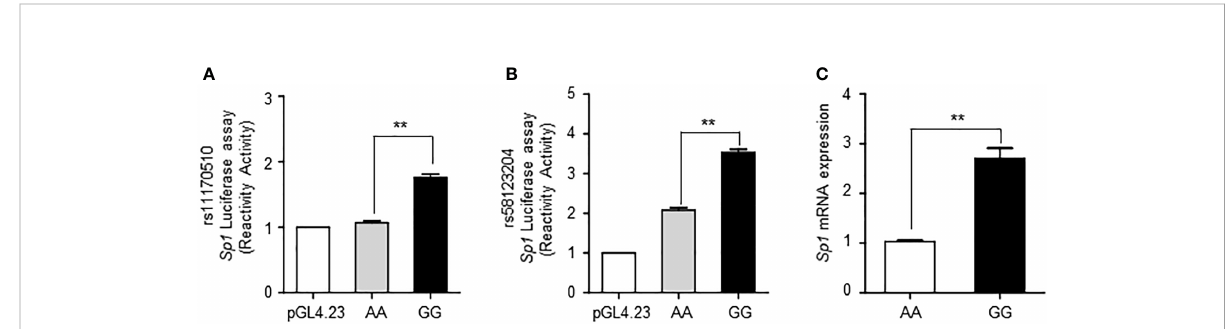
FIGURE 2 Functional effects of SNPs rs11170510 and rs58123204 on Sp1 expression. (A) HEK293 cells were transfected with the mock vector (pGL4.23 vector), major A allele of the rs11170510 or minor G allele of the rs11170510-luciferase reporter constructs. Cells were subjected to a luciferase assay. (B) HEK293 cells were transfected with the mock vector (pGL4.23 vector) or major A allele of the rs58123204 or minor G allele of the rs58123204- luciferase reporter constructs. Cells were subjected to a luciferase assay. (C) Quantitative PCR analysis of Sp1 mRNA expression in peripheral blood mononuclear cells (PBMCs) with major A allele or minor G allele of rs11170510 and rs58123204 (n = 10, major homo AA; n = 10, minor homo GG). Experiments were repeated at least three times. Graphs are indicative of the mean ± standard deviation (SD). **p < 0.01 (two-tailed unpaired Mann –